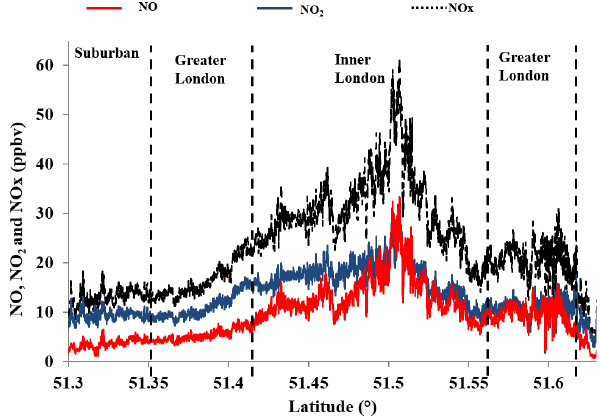
Figure 4. City cross section of 1km averaged NO, NO 2 and NO x mixing ratios across Greater London at 360 ± 10ma.g.l. during RF 5.